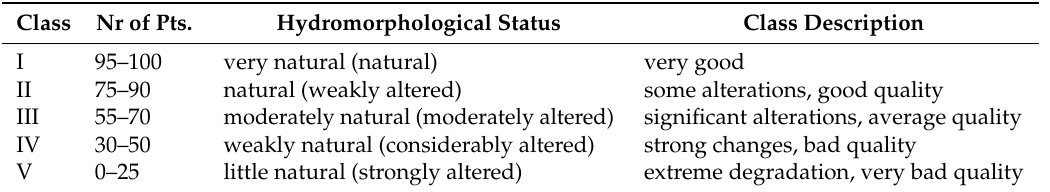
Table 3. Classification of the hydromorphological status according to QBR (agreement with WFD). Class Nr of